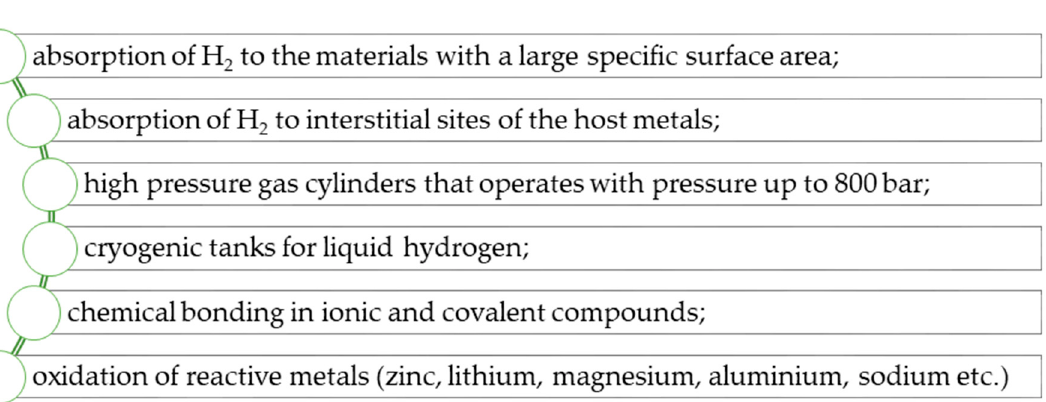
Figure 4. Phenomena and methods used in hydrogen storage methods developed over the past several years (on the basis of [12]).